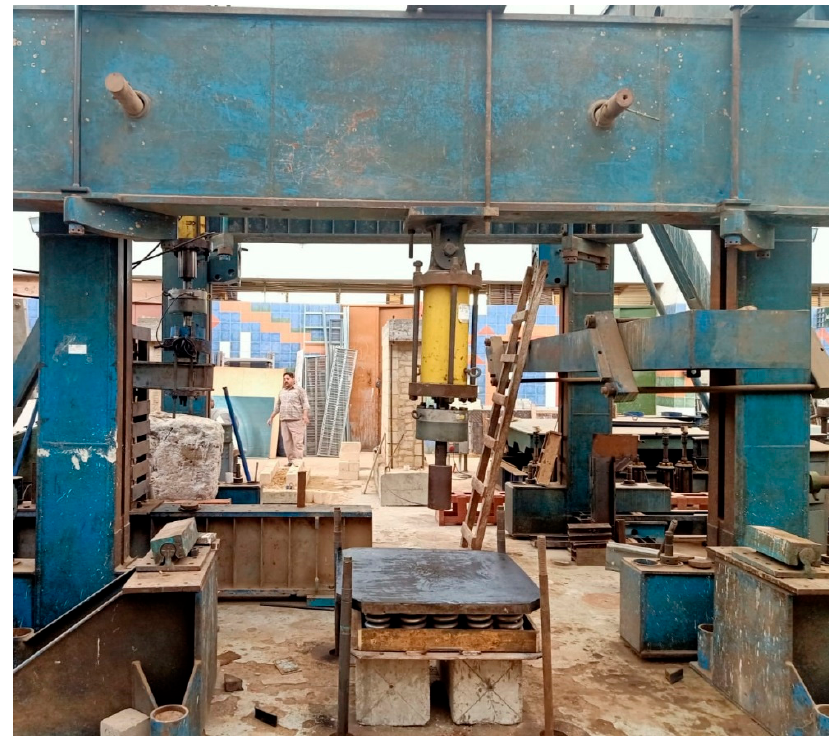
Figure 4. Concrete slab loading frame.